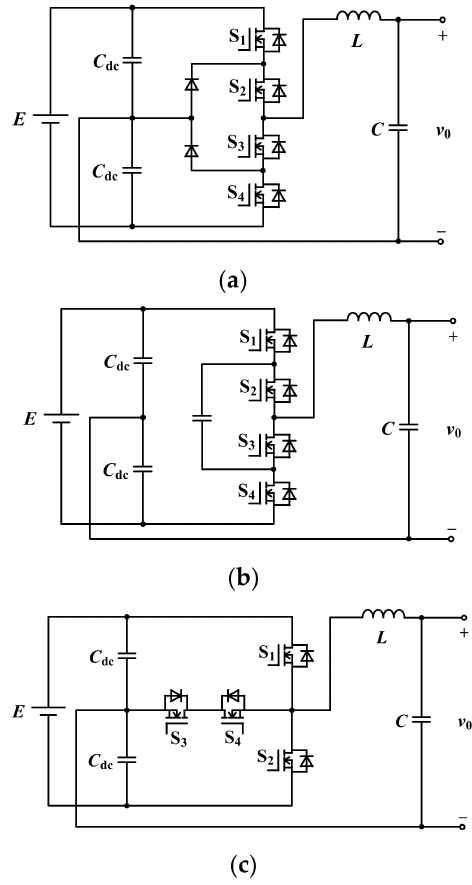
Figure 9. ( a ) I-type three-level inverter topology. ( b ) Flying-span-capacitor-type three-level inverter topology. ( c ) T-type three-level inverter